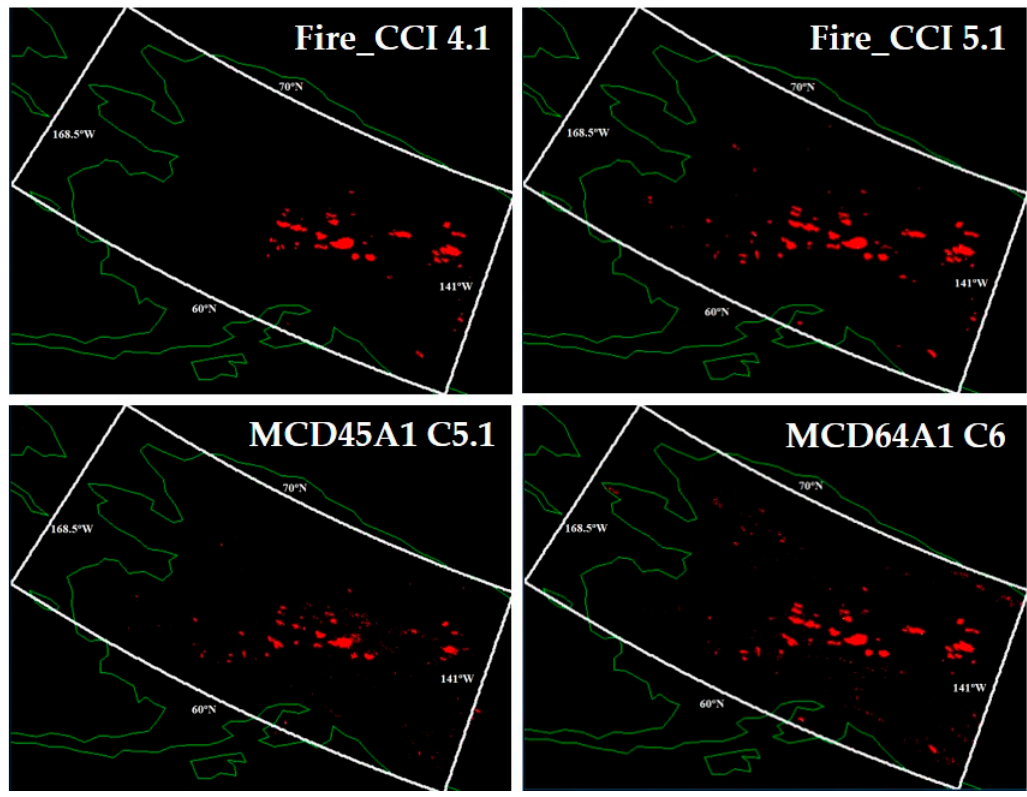
Figure 4. Annual burned area maps for the Alaskan region in 2009. Red, burned pixels; white, study region; green, political borders and coastlines.